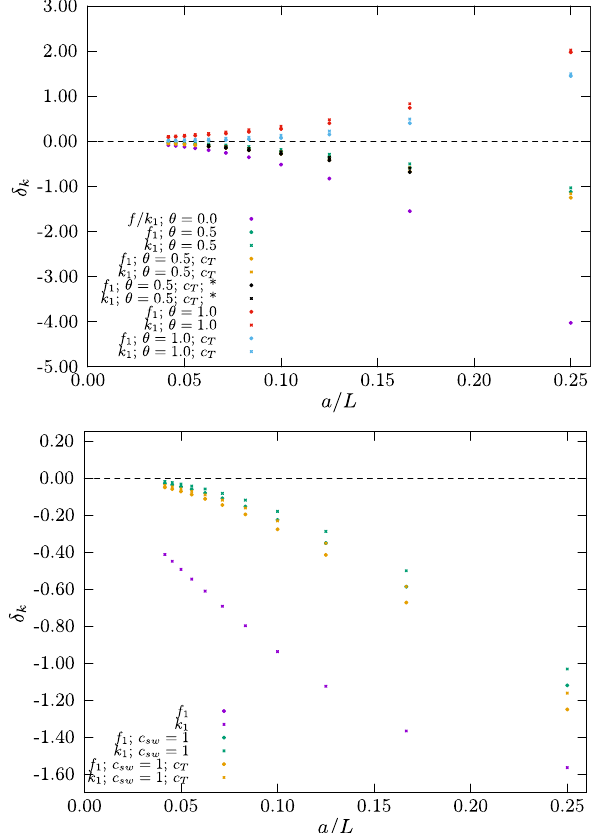
Fig. 2 Upper panel: cutoff effects as a function of a / L for the various schemes considered and the O ( a ) improved fermion action. Results with and without operator improvement are provided. Results with both am ( 1 ) cr ( L / a ) and am ( 1 ) cr ( ∞ ) are plotted for comparison. Lower panel: zoom-in displaying only results for the schemes with θ = 0 . 5 (which will be the one employed in the non-perturbative computation), also including those with an unimproved fermion